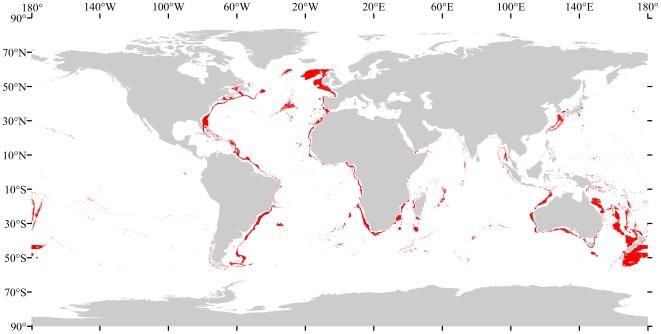
Binary predicted presence map for scleractinian framework-forming corals based on the 10th percentile training presence, which omits the 10% most extreme presence observations as they may represent recording errors.White background indicates that these species are not likely to be found, red indicates probable presence.